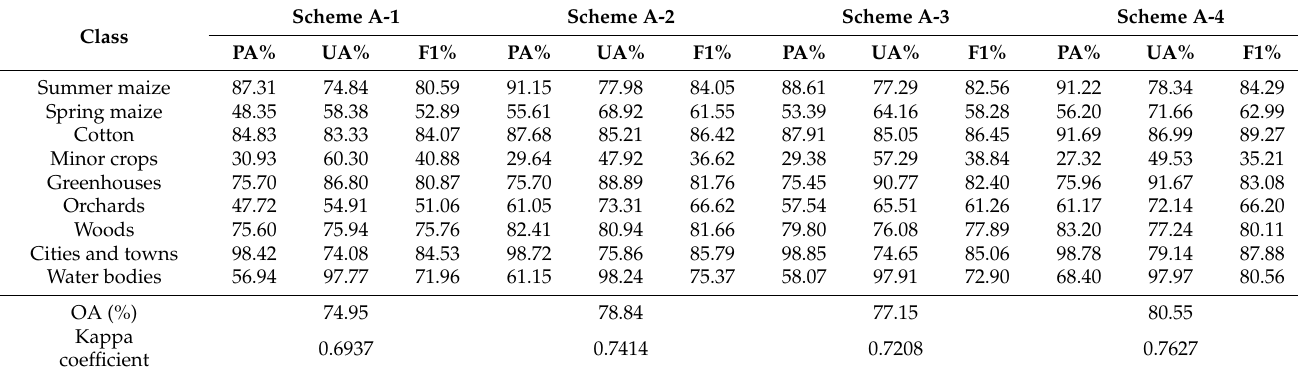
Table 8. Classification accuracy statistics of red edge texture